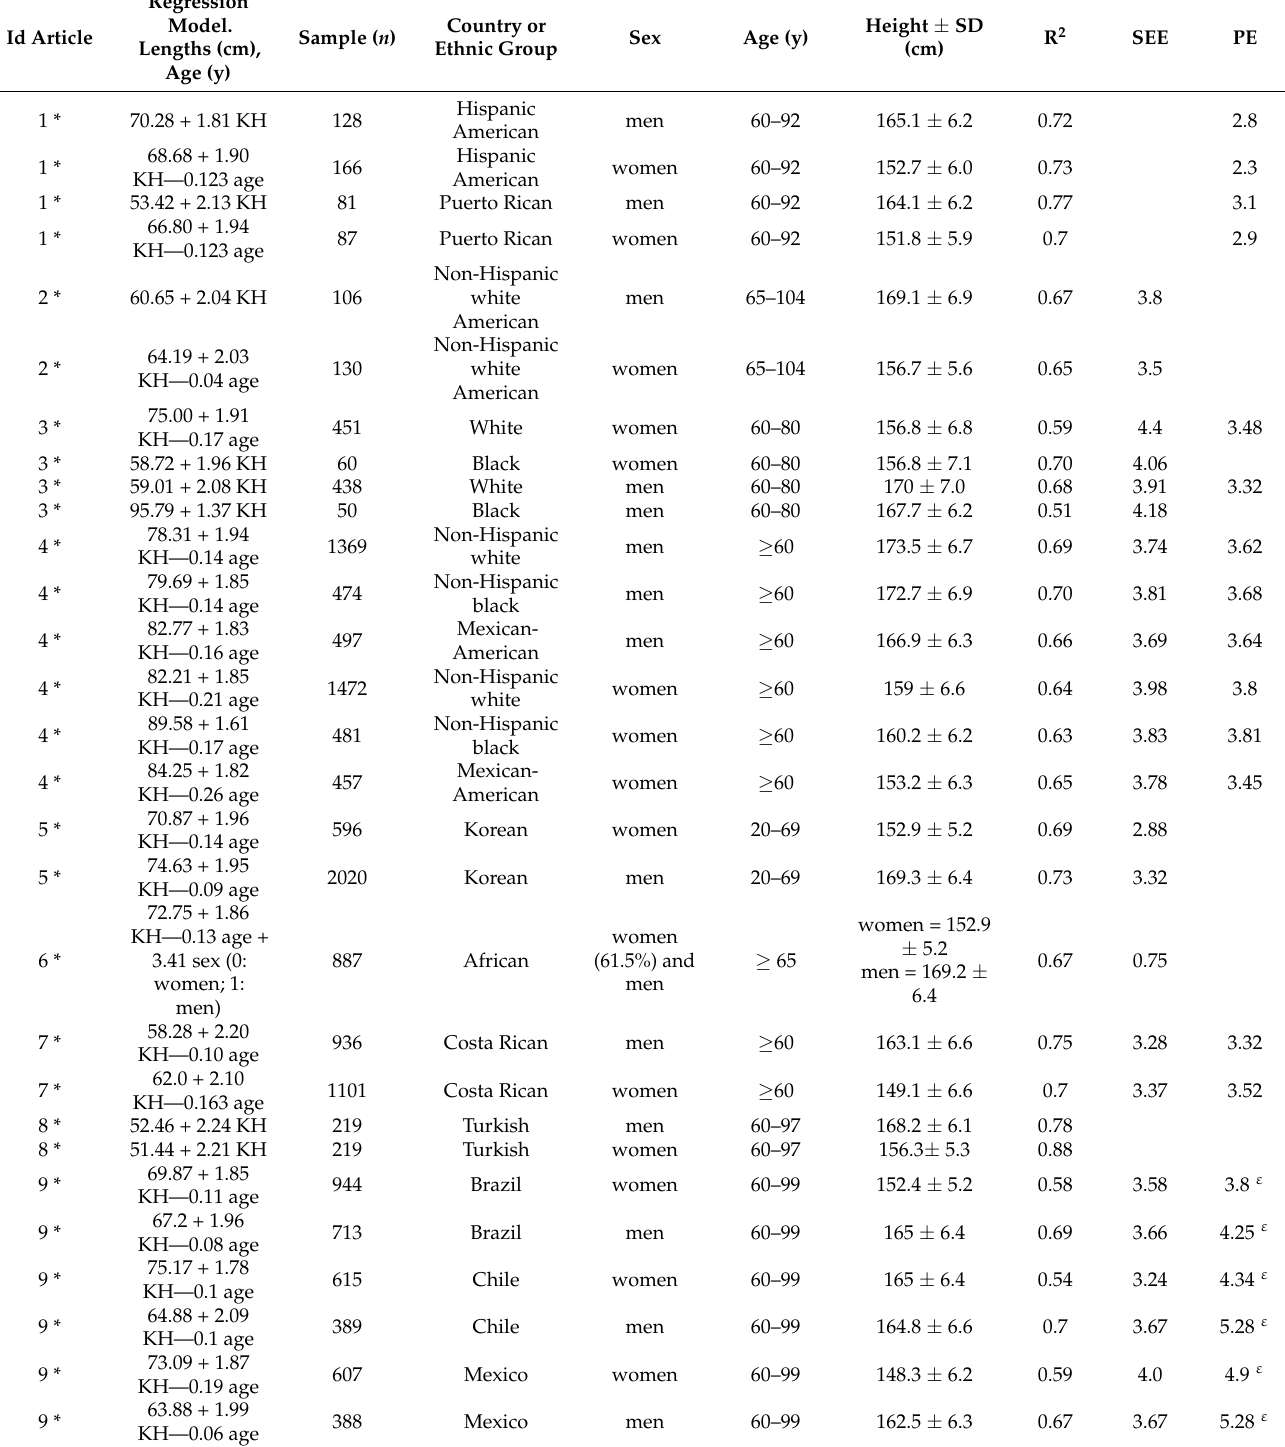
Table 4. Regression models found in the literature to measure maximum height in adults ≥ 60 years